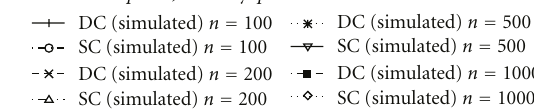
Figure 4: Static counter (SC) and dynamic counter (DC) security performances